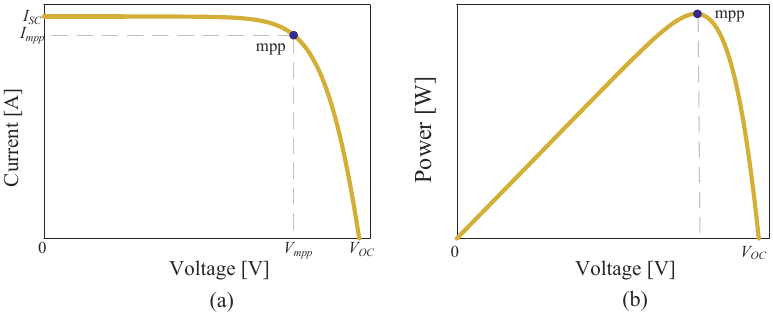
Figure 2. The performance curves of PV cells: ( a ) I-V characteristic curve. From this curve, one can find the short-circuit current, open-circuit voltage, voltage and current at maximum power, fill factor, and resistance at maximum power. ( b ) P-V curve, which shows the maximum output power.